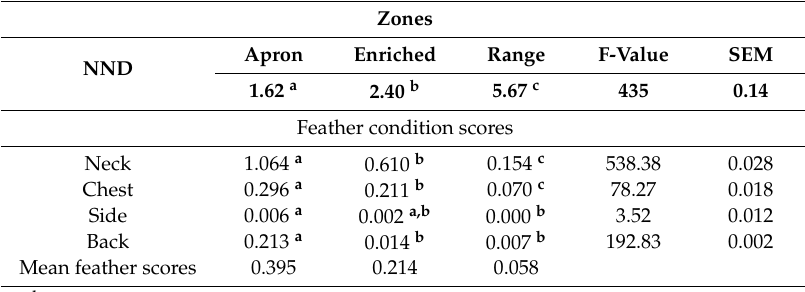
Table 5. NND and feather condition for hens in apron, enriched belt and outer